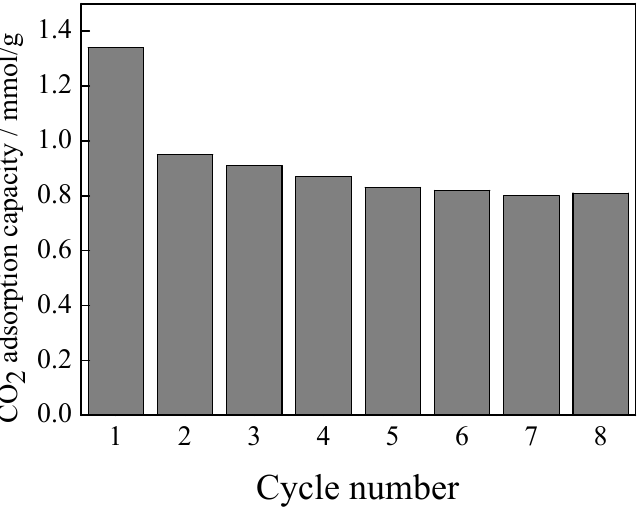
Figure 9. CO 2 adsorption capacity of [APMIM]Br-modified magnesite for eight cycles. Compared with calcined magnesite and other MgO-based adsorbent in our previ- ous work [22], the CO 2 adsorption capacity of the [APMIM]Br-modified magnesite is 1.34 mmol/g, slightly lower than the calcined magnesite in the presence of water,